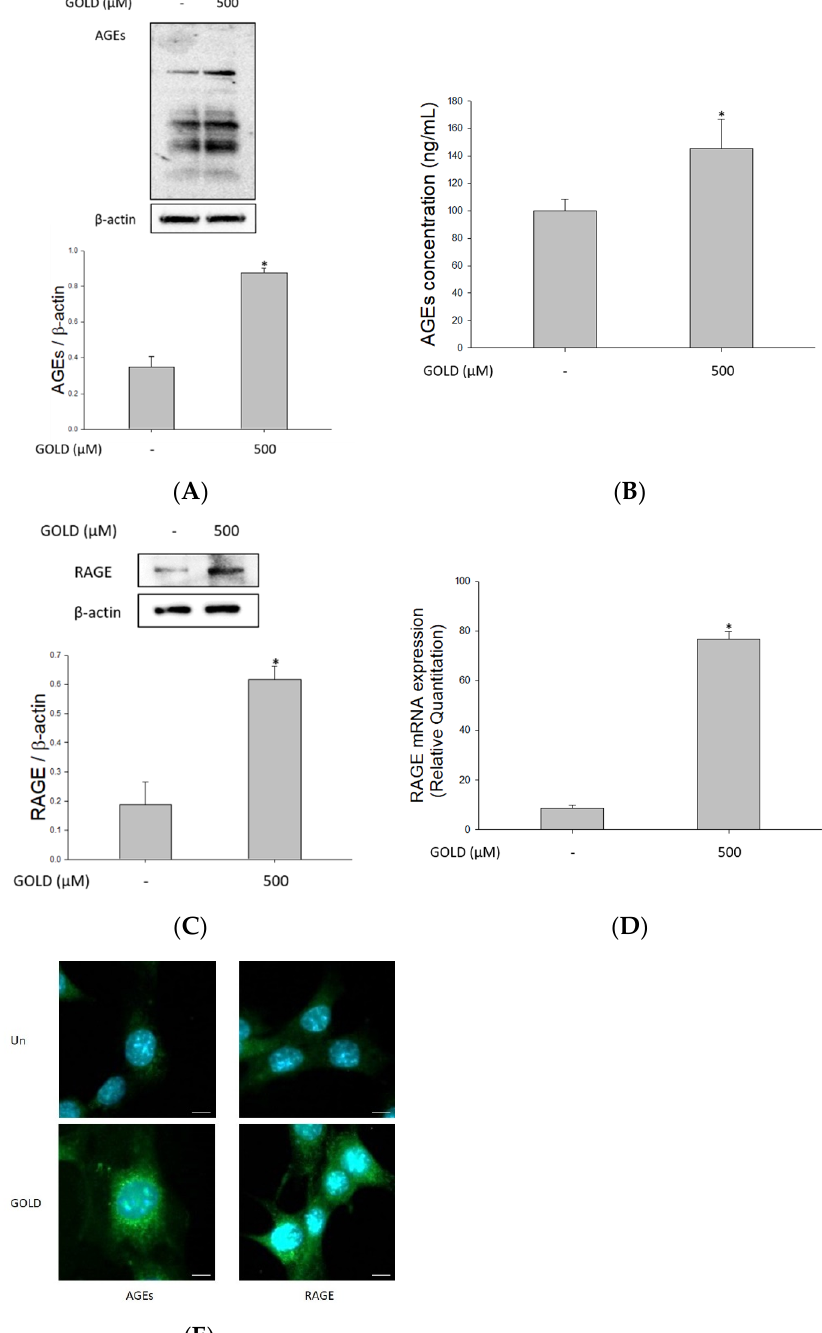
Figure 1. Effects of advanced glycation end products (AGEs) and expression of receptor for AGEs (RAGE) levels. SV40 MES 13 cells were stimulated with the glyoxal-lysine dimer (GOLD; 500 µ M) for 24 h. ( A , C ) The protein levels of AGEs and RAGE were determined using Western blotting, with β-actin as an internal control. ( B ) AGE production was measured using an ELISA kit (CELL BIOLABS, STA-817). ( D ) RAGE expression was determined using RT-qPCR. GAPDH was used as an internal control. ( E ) SV40 MES 13 cells were incubated with a vehicle (medium) or GOLD for 24 h. After stimulation, cells were treated with anti-AGE and -RAGE primary antibodies, followed by fluorescein isothiocyanate (FITC)-labeled anti-rabbit IgG. Cells were detected using fluorescence microscopy at ×400 magnification. Scale bar, 20 μm. Data are expressed as the mean ± SEM of three independent experiments. * p < 0.05 indicates a significant difference compared to the untreated group.